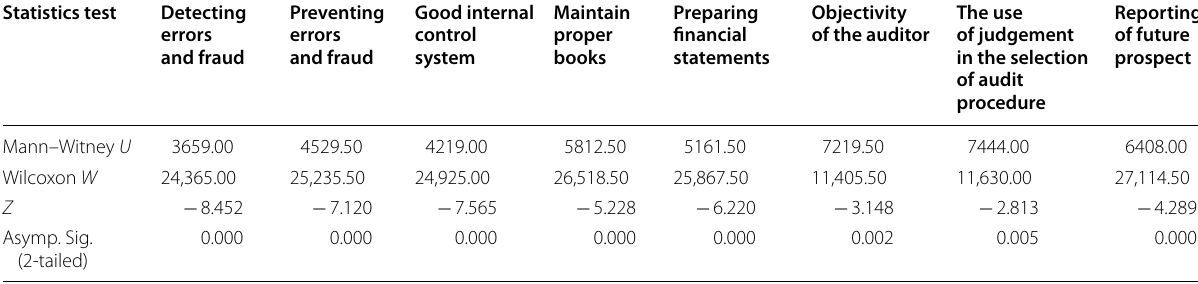
Statistics test